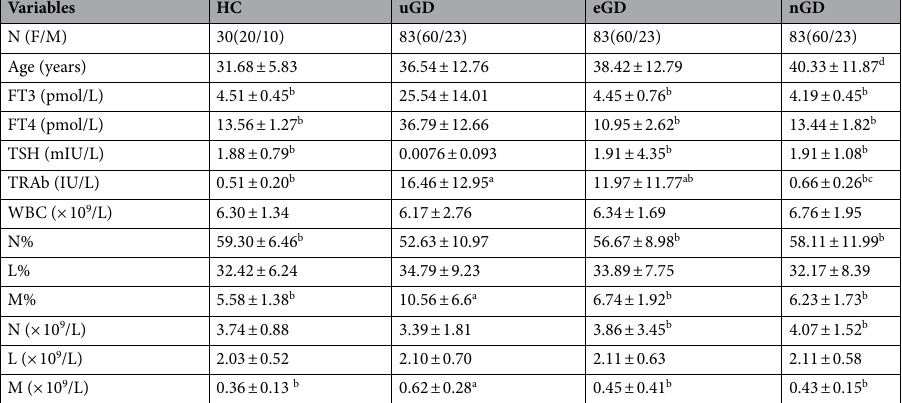
Table 1. General characteristics of the study population. HC healthy controls, uGD untreated GD, eGD euthyroid GD, nGD TRAb-negative GD, FT3 free triiodothyronine, FT4 free thyroxine, TSH thyroid stimulating hormone, TRAb thyrotropin receptor antibody. Compared to HC, a P < 0.001; compared with uGD, b P < 0.001; compared with eGD, c P < 0.001; compared to HC, d P < 0.05; P value was determined by Mann– Whitney U test.